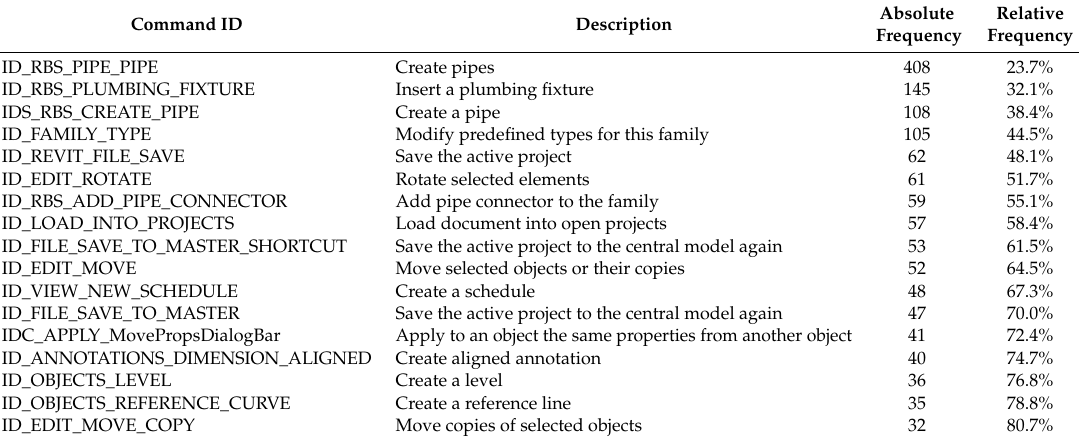
Table A4. Contributory commands most frequently used by the plumbing